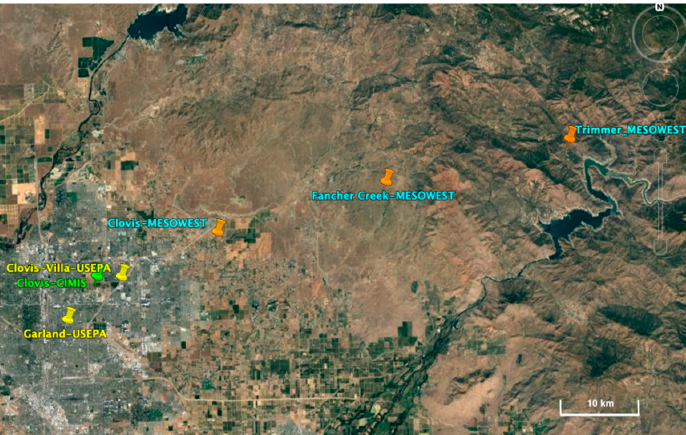
Figure 2. Locations of air quality and meteorology monitoring stations; Garland (USEPA), Clovis- Figure Villa (USEPA), Clovis (CIMIS), Clovis (MESOWEST), Fancher Creek (MESOWEST), and Trimmer (MESOWEST) sites. Notes: USEPA—United States Environmental Protection Agency; CIMIS— California Irrigation Management Information System; MESOWEST—this is an archive of meteorological data across the United States.